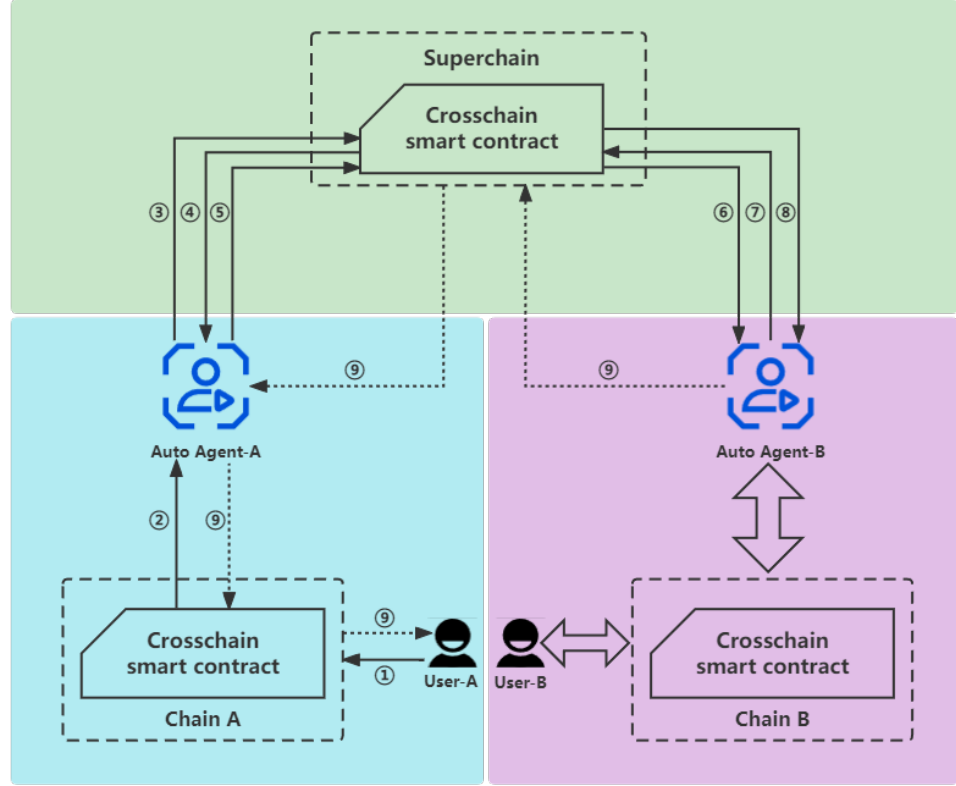
Figure 4. The framework of the cross-chain identity authentication and authority control